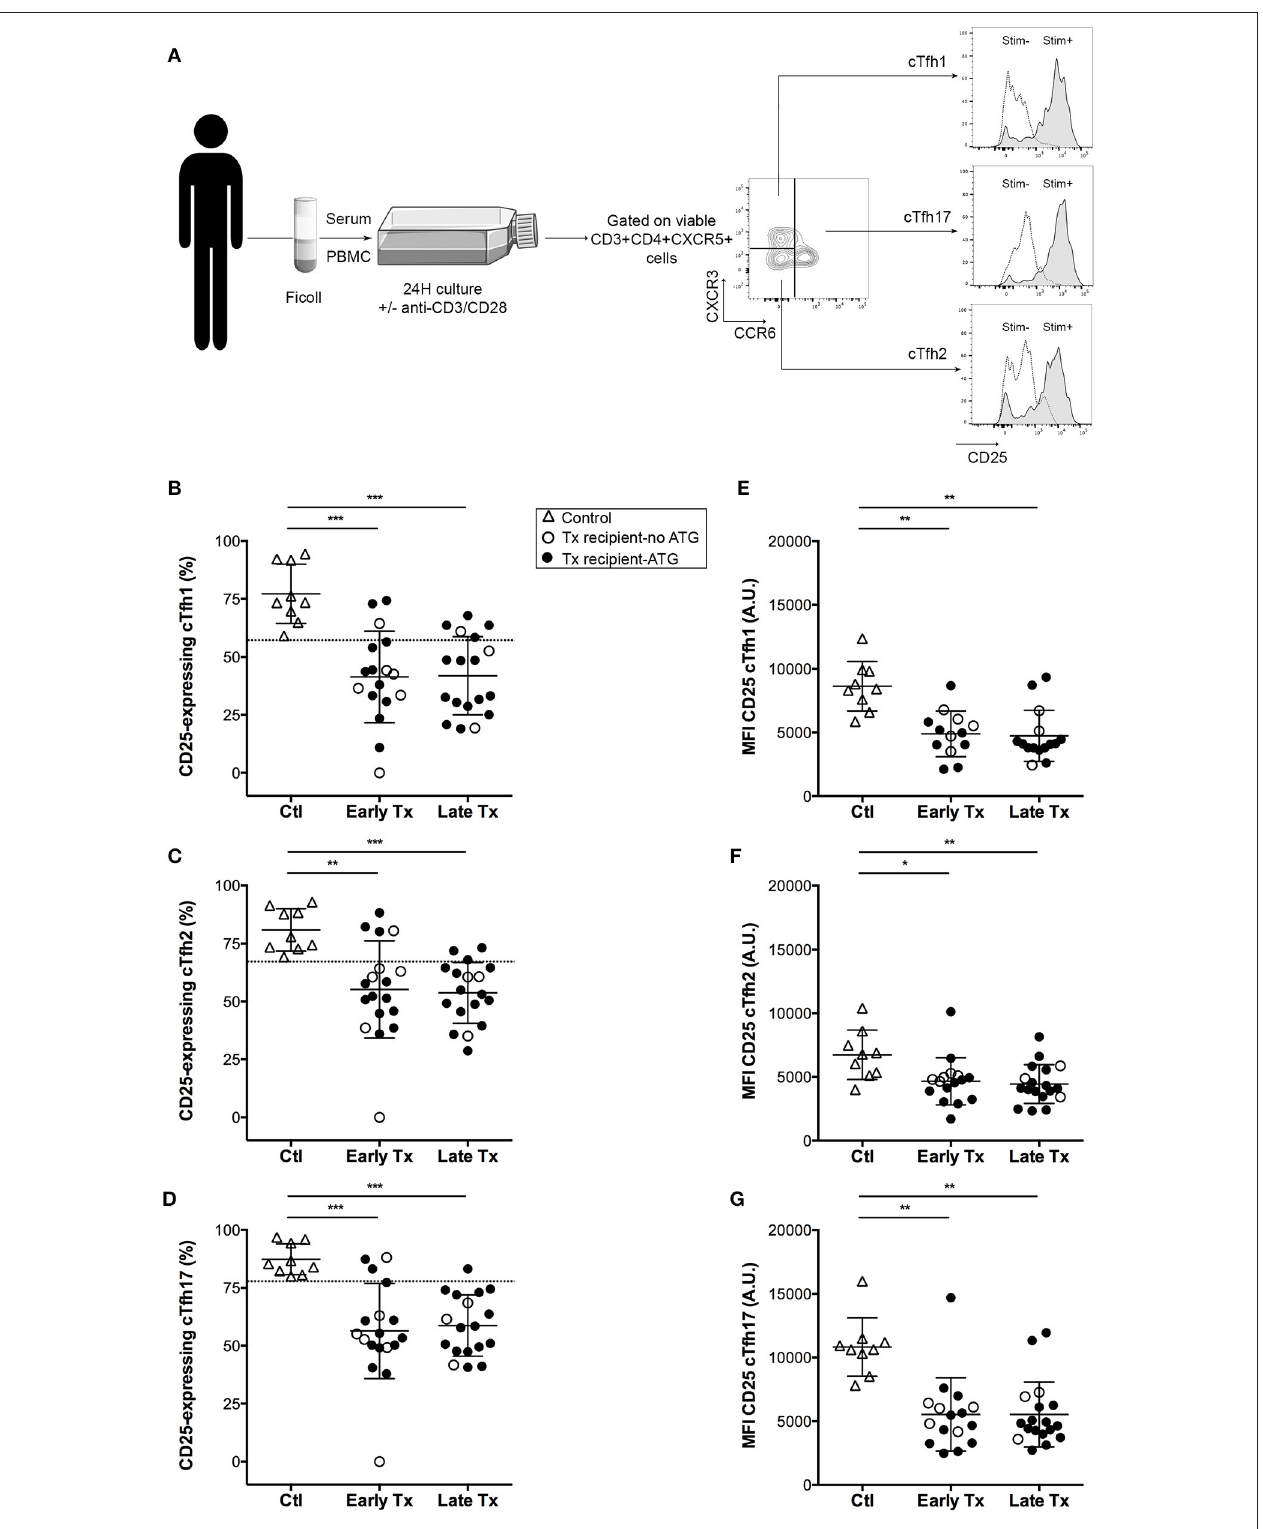
FIGURE 3 | Comparison of the activation profile of cTfh of controls and transplants patients. (A) Graphical summary of the procedure used to evaluate the residual activatability of the three subsets of cTfh. PBMC of patients were collected just before vaccination. The level of expression of CD25 was measured by flow cytometry on the surface cTfh, after 24h culture in patient’s own serum with (gray profiles, Stim + ) or without (open profiles, Stim–) stimulation with anti-CD3/CD28 microbeads.